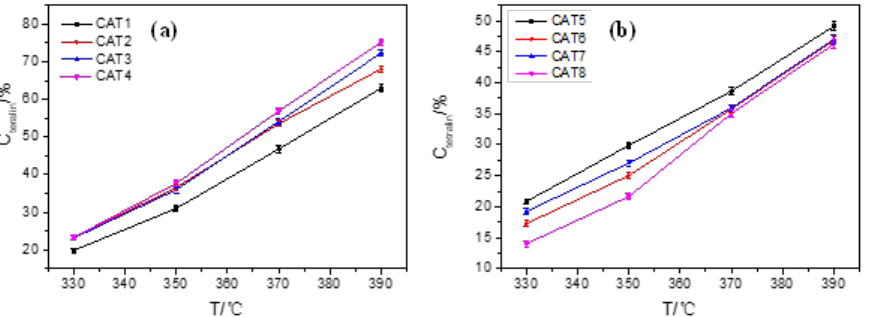
Figure 7. The relationship of conversion and temperature over catalysts ( a ) CAT1 – CAT4 and ( b ) CAT5 –